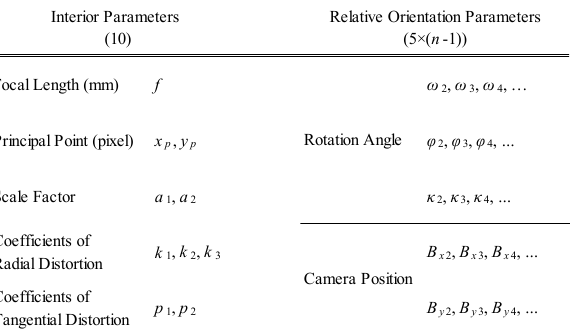
Table 1. Unknown parameters of relative orientation